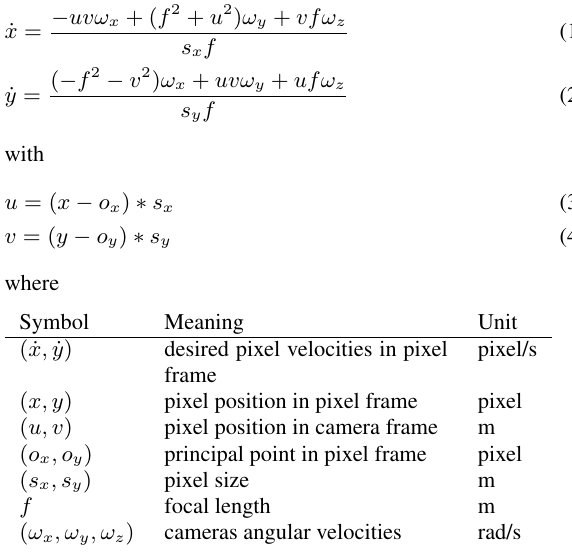
Figure 5: Raw gyroscope data during aggres- sive flight. Peaks at the end are caused by the landing